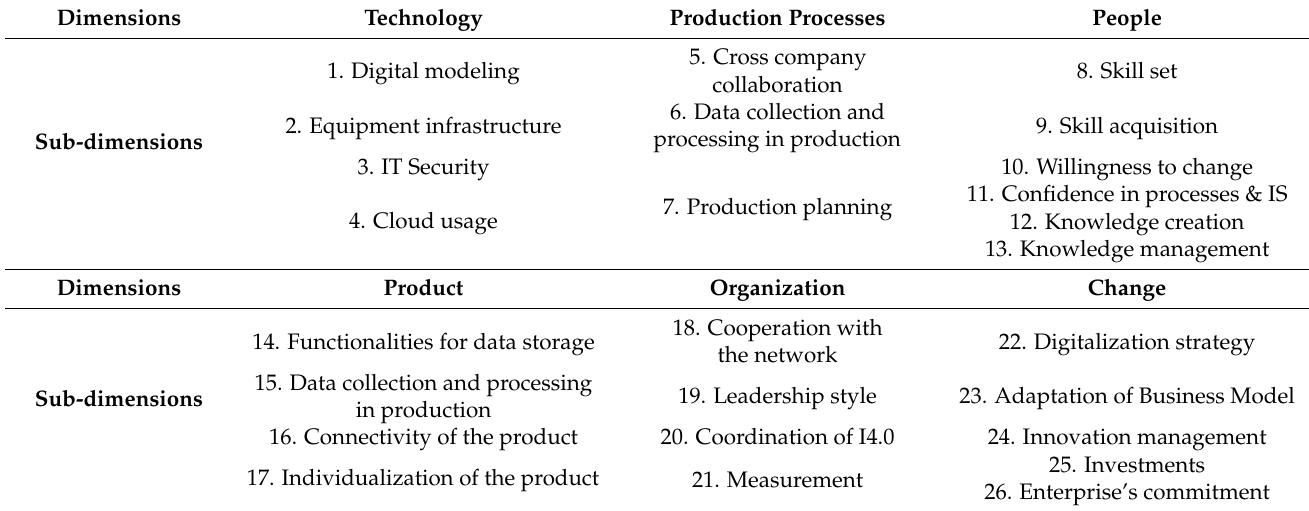
Figure 2. Framework’s sub-dimensions and impact of hurdles. Table 3. Proposed model